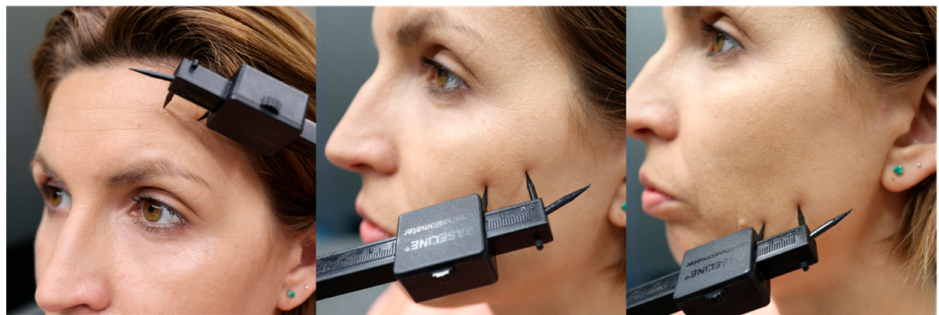
Figure 2. Two-point discrimination assessment. Measuring at V1, V2 and V3 areas.